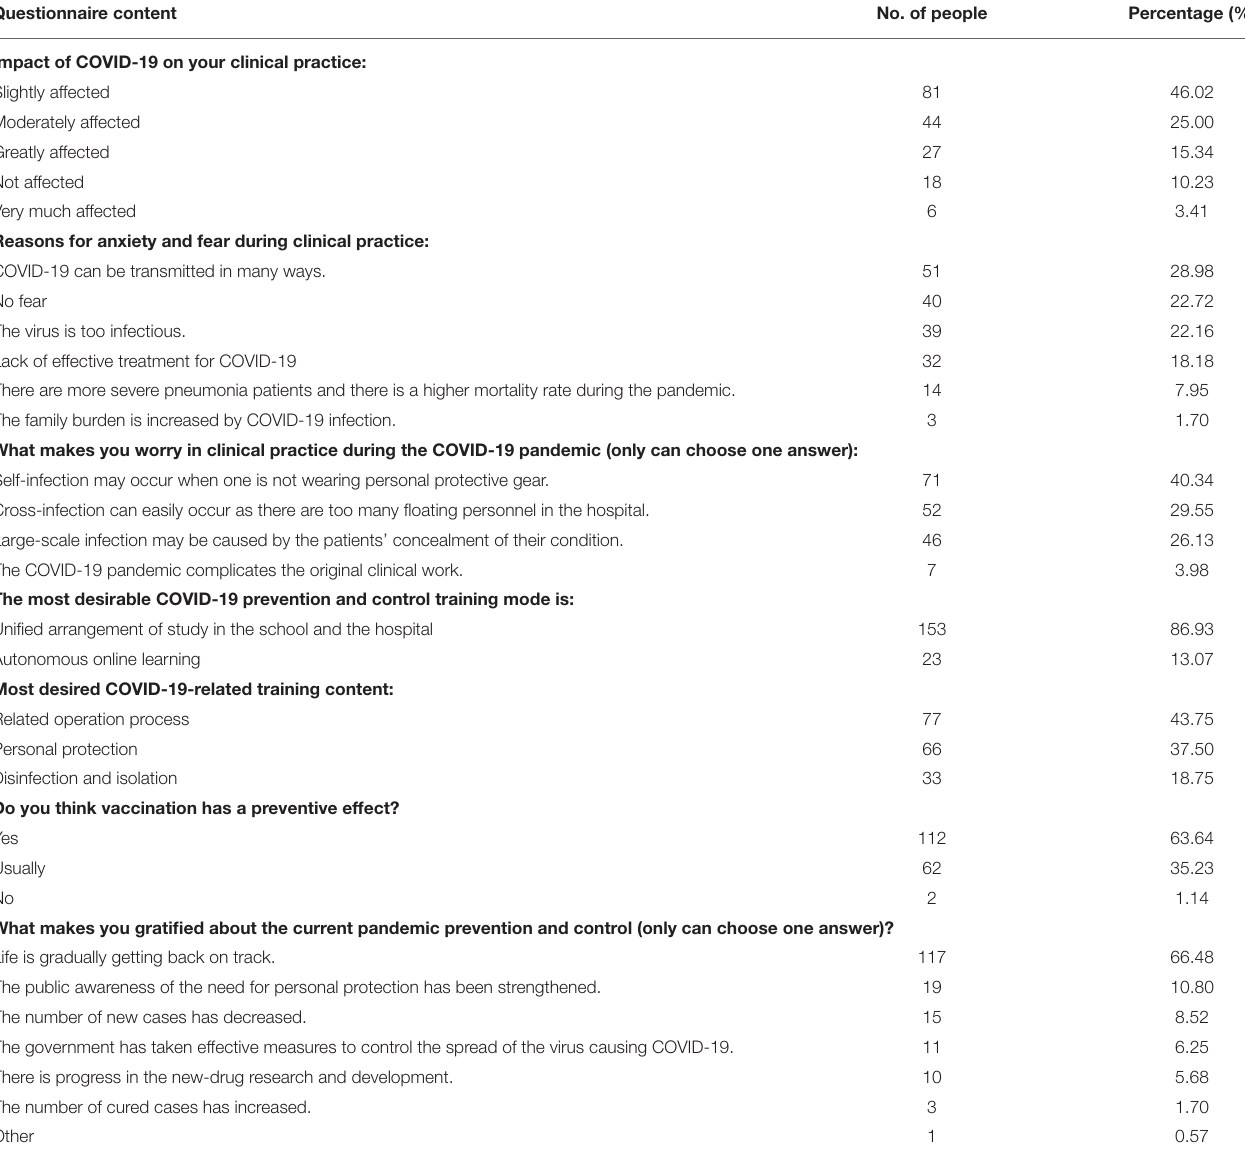
TABLE 2 | Results of the questionnaire survey on the clinical medical post-graduates’ cognitive attitudes toward the COVID-19 pandemic. Questionnaire